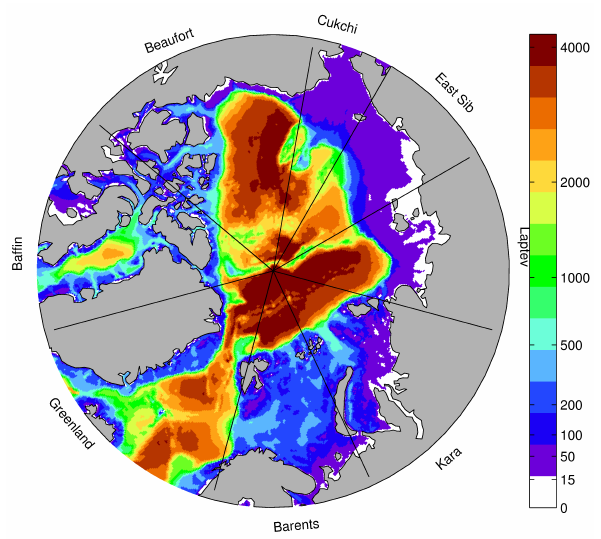
Fig. 2. Bottom topography (m) and boundaries of geographical